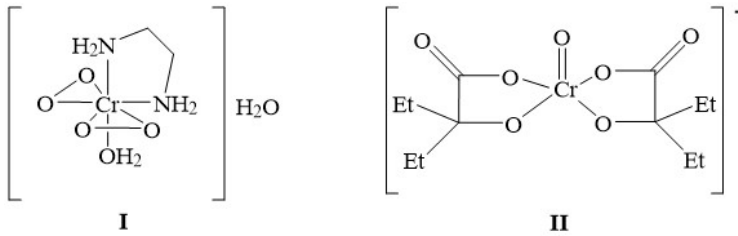
Figure 1. Aquaethylenediaminebis(peroxo)chromium(IV) hydrate ( I ) and (bis(2 ‐ hydroxy ‐ 2 ‐ ethylbutyrato)oxochromate(V) ( II )